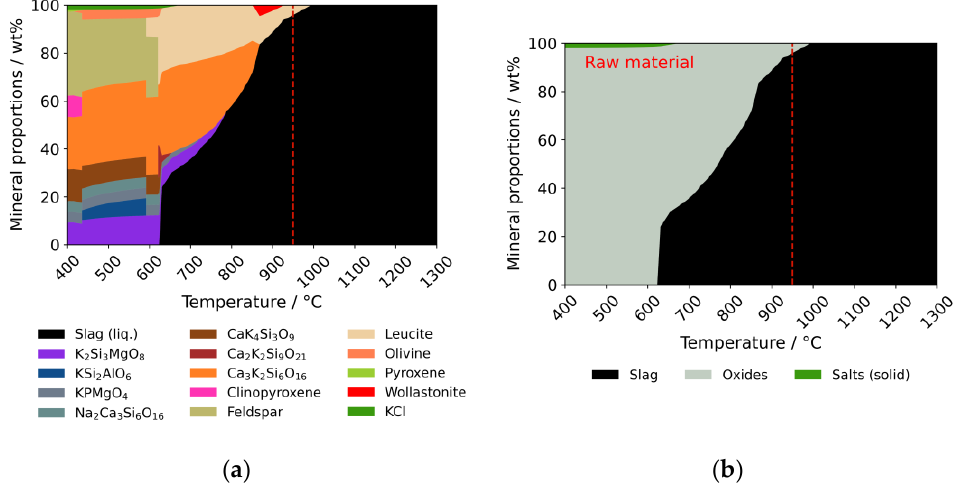
Figure 14. Calculated mineral proportions of raw wheat straw ash under gasification-like conditions. ( a ) Overview phase map, where all predicted phases are mapped. ( b ) Summarized phases (mainly oxides and molten slag). The dashed red line denotes the gasification temperature of 950 °C.